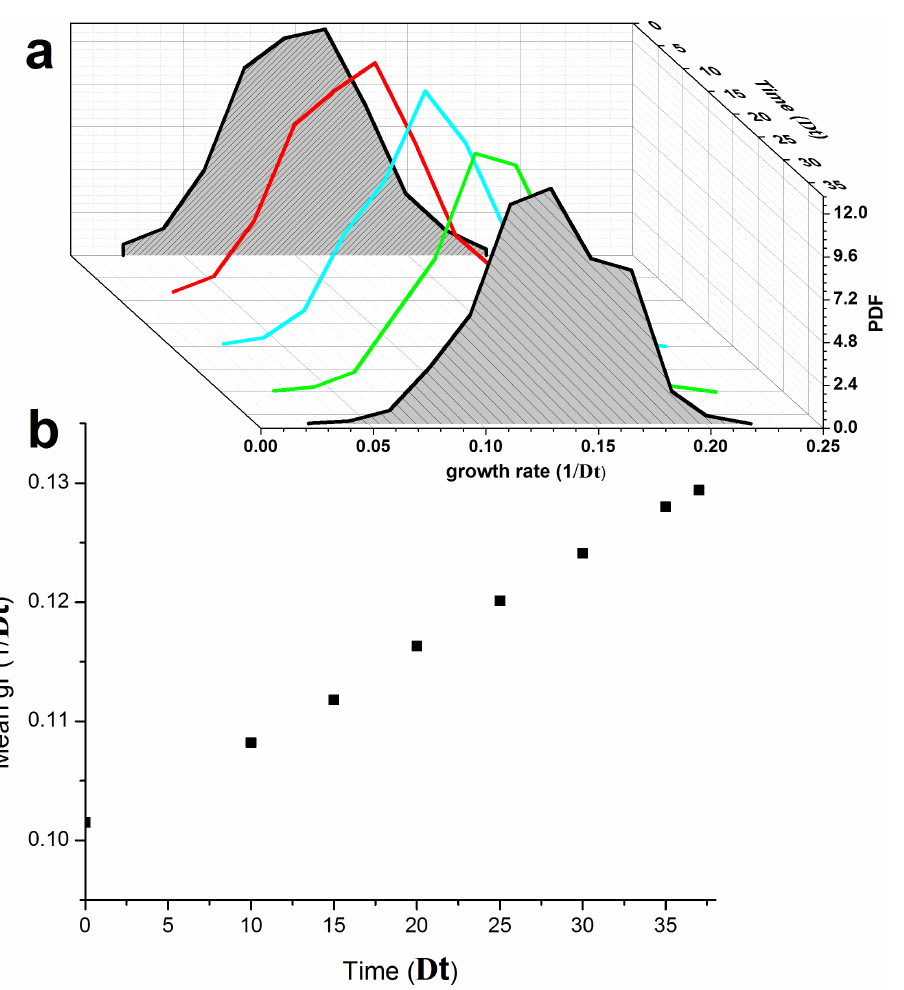
Figure 5. Monte-Carlo simulations of an evolving population. (a) Growth-rate distributions as a function of propagation time, computed from a Monte Carlo simulation of the evolution of a population with a stably inherited growth-rate in a lineage across generations. There are 1000 cells at the initial time point serving as the seeds for the evolving lineages. In each lineage the growth-rate is extracted from a Gaussian distribution. (b) The mean growth rate in the simulation increases lineally as a function of time. The mean growth rate changes by , 30% within , 5 generations. The growth-rate is measured in units of the inverse simulation time.